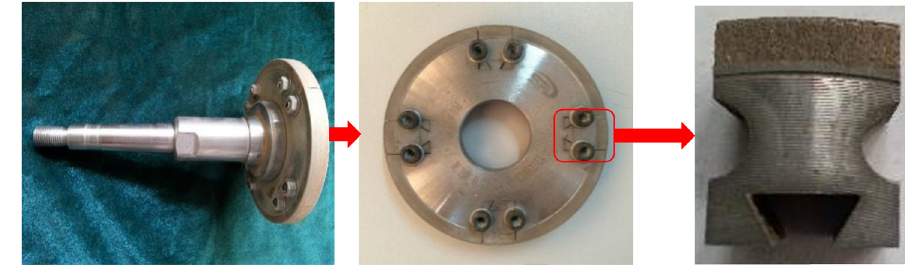
Figure 3: Structure diagram of the wedge grinding